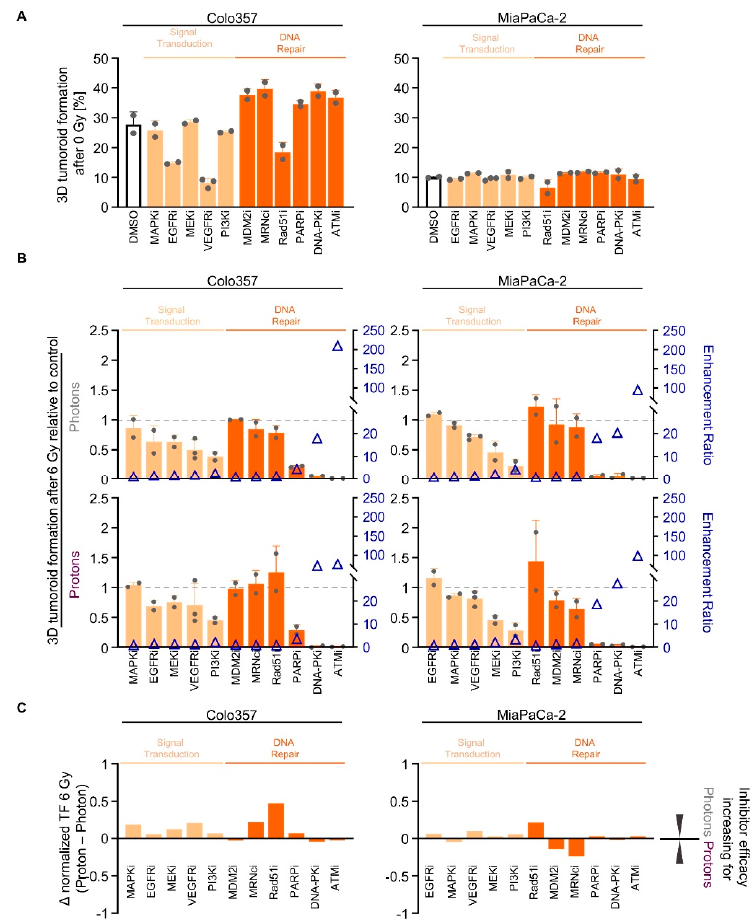
Figure 4. Targeting of signal transduction and DNA repair enzymes sensitizes PDAC cell cultures to photon and proton irradiation. ( A ) 3D tumoroid formation capacity of unirradiated Colo357 and MiaPaCa-2 cells 1-h pretreated with indicated pharmacological inhibitors (experimental set-up shown in Figure S2A); ( B ) Normalized 3D PDAC tumoroid formation capacity upon 1-h inhibitor pretreatment combined with 6-Gy photon or proton irradiation. Data in the order of cell-line-specific inhibitor e ffi cacy after photon irradiation. Enhancement ratio (tumoroid formation capacity after 6 Gy control treatment / tumoroid formation capacity after 6 Gy inhibitor treatment) are indicated as blue triangles; ( C ) Di ff erences in the radiosensitizing e ffi cacy of inhibitors visualized by ∆ values of normalized tumor formation capacity (tumoroid formation capacity after 6 Gy of protons - tumoroid formation capacity after 6 Gy of photons). All results show mean ± SD ( n ≥ 2); ∆ : delta, i: inhibitor, TF: tumoroid